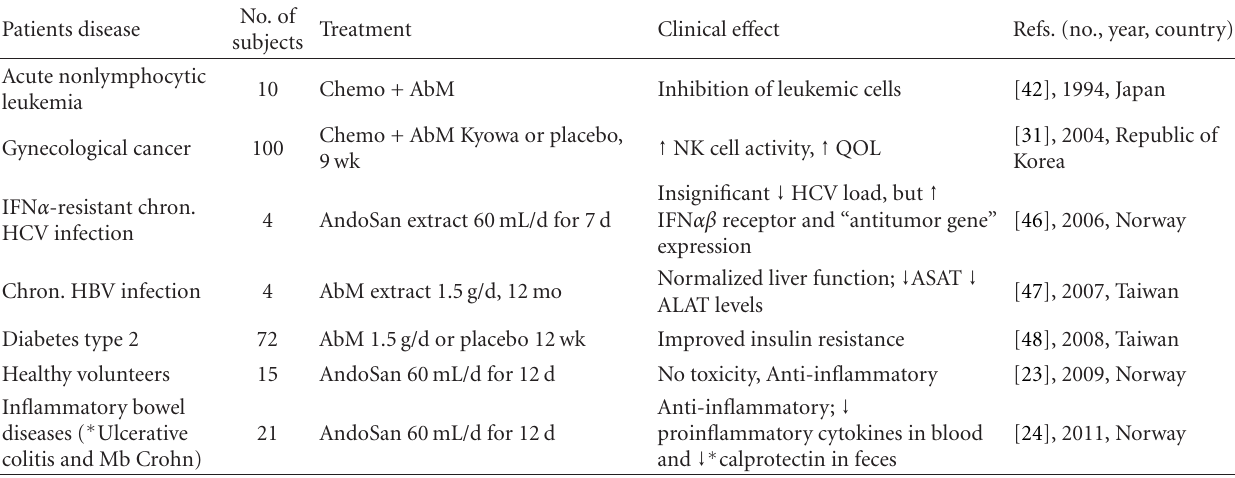
Table 2: Clinical studies with Agaricus blazei Murill